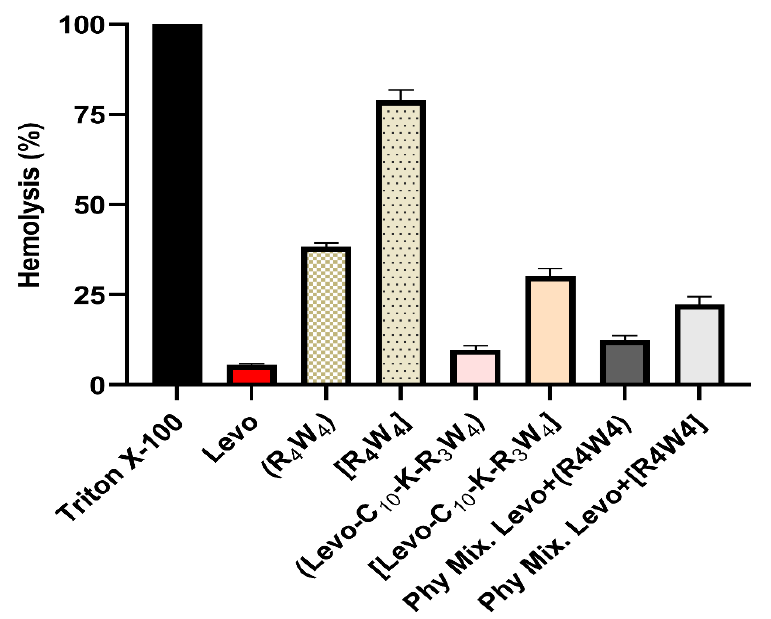
Figure 2. The data represent the percentage hemolysis of the Levo and the peptides (linear and cyclic) alone and their chemical conjugates and physical mixture at 500 µg/mL. The experiment was conducted in triplicate.